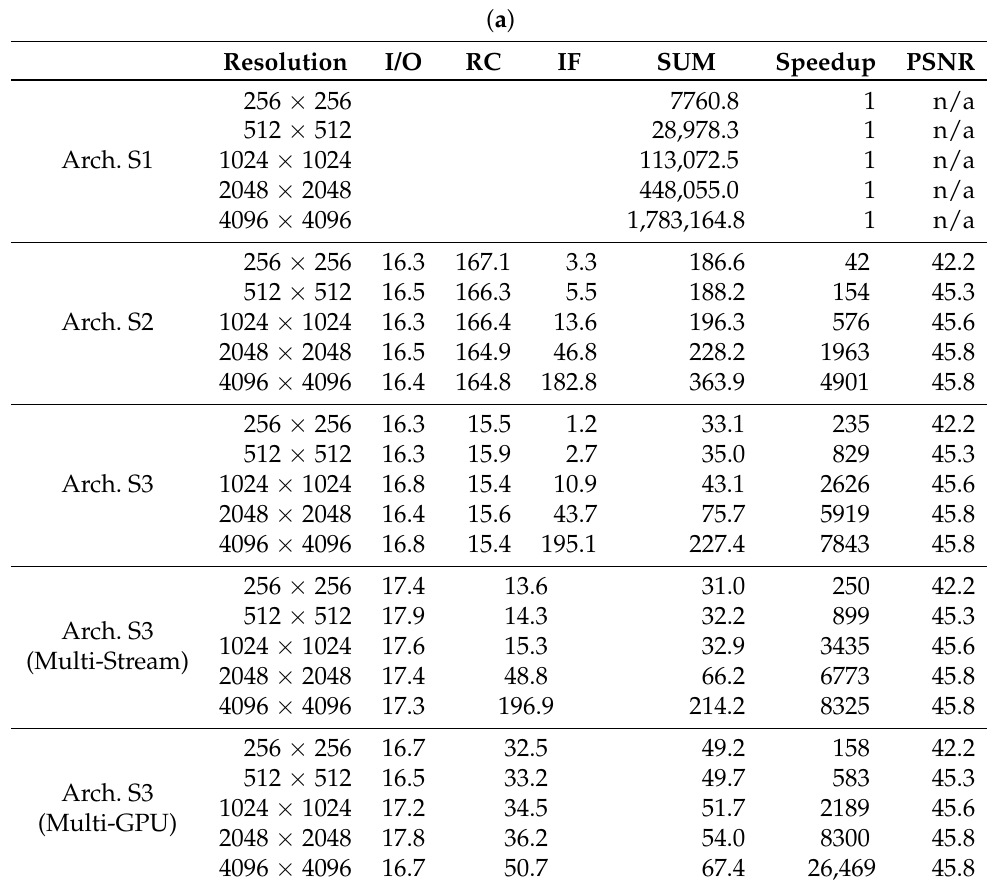
Table 7. Processing times in BP-VISAR architectures with sub-aperture processing. ( a ) Non- overlapped mode, α = 0, unit: ms, dB. ( b ) Overlapped mode, α = 0.8, unit: ms,